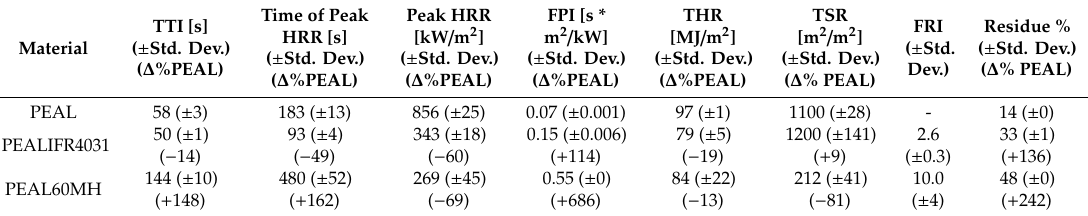
Table 4. Recap of cone calorimeter main results for PEAL, PEALIFR4031, PEAL60MH:TTI, Time of Peak HRR, Peak HRR, FPI, THR, TSR, FRI and Residue. In brackets, the standard deviation and the percentage variation of the parameters of the compounds compared to neat